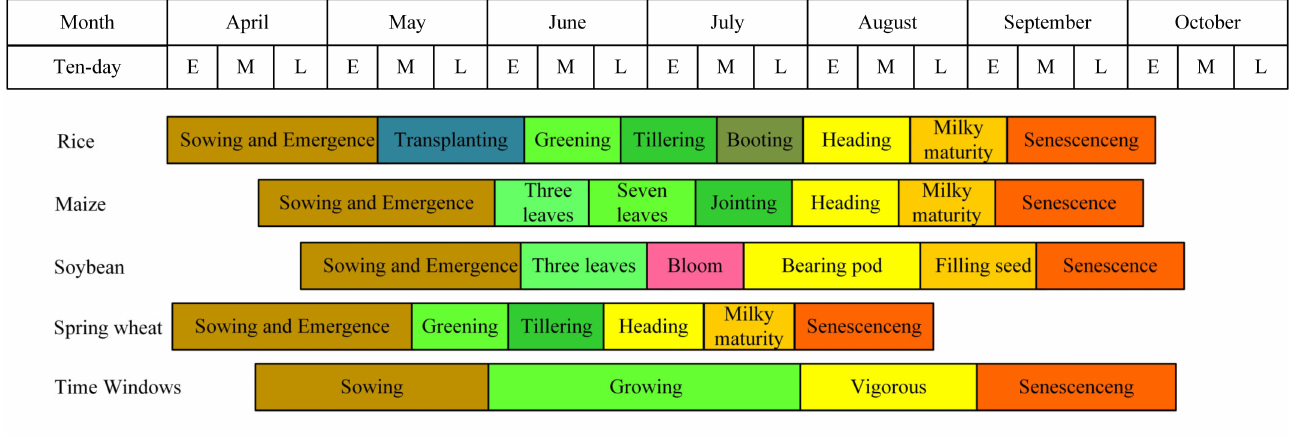
Figure 4. Phenological calendar of major crops and simplified phenological time window.